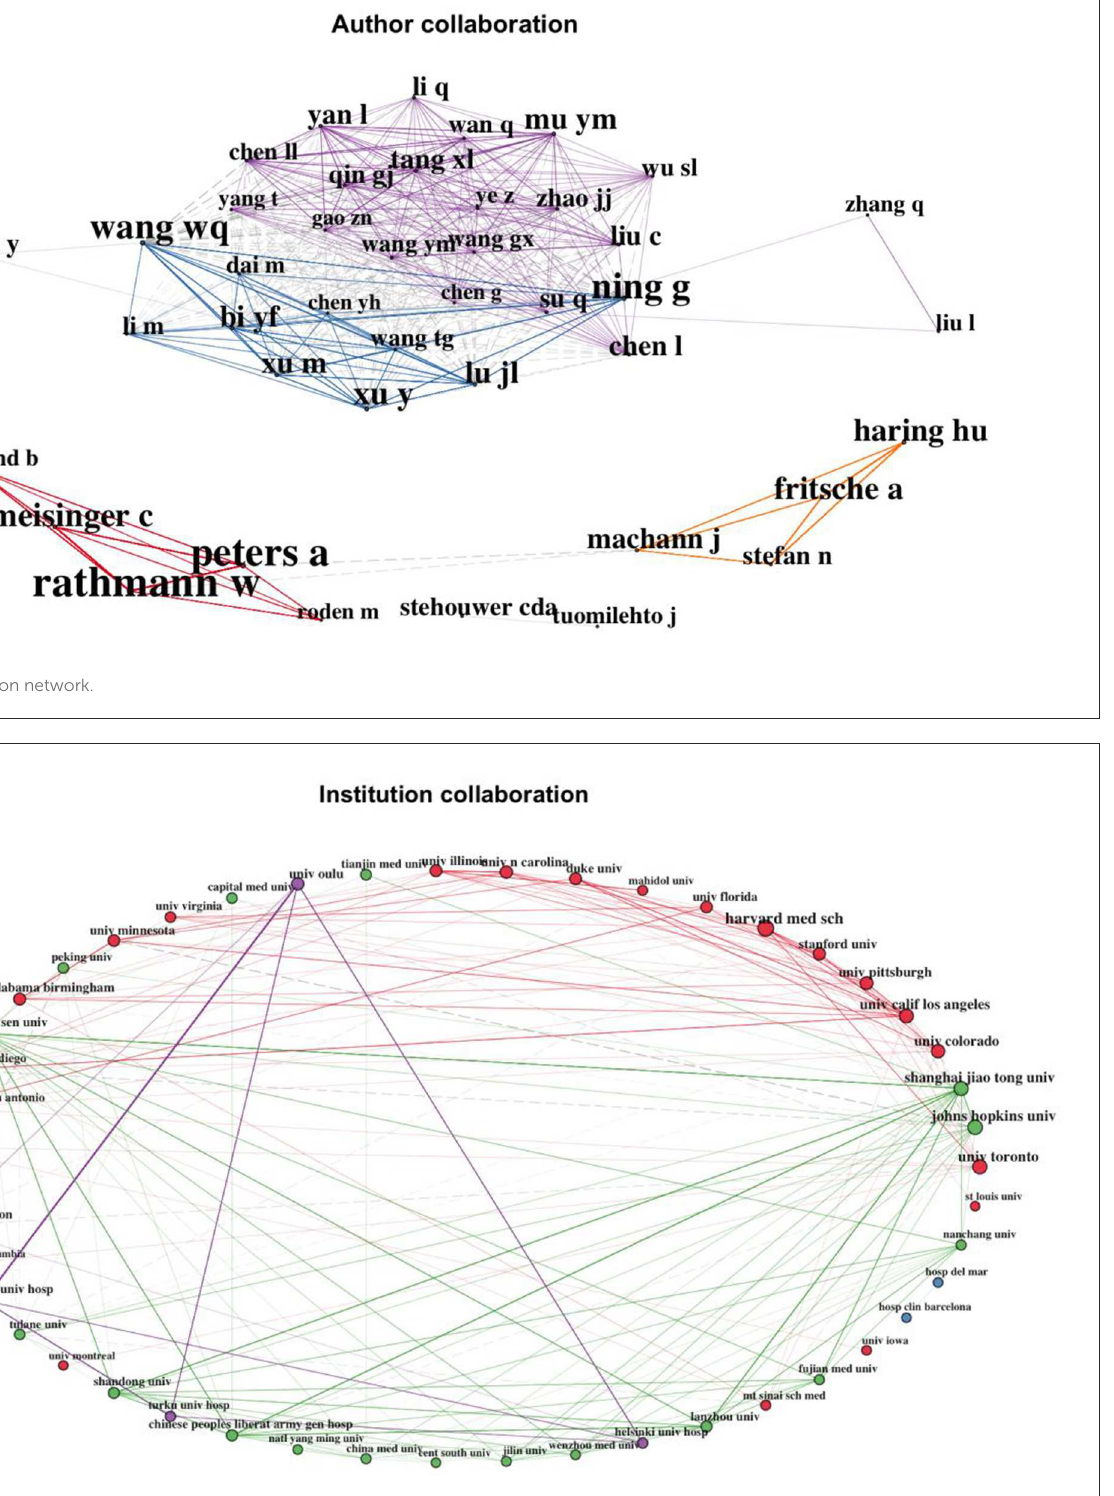
ranks sixth in international collaboration. Therefore, as the country with the highest incidence of diabetes, China should strengthen international collaboration in the future to improve the ability to diagnose, prevent, and treat